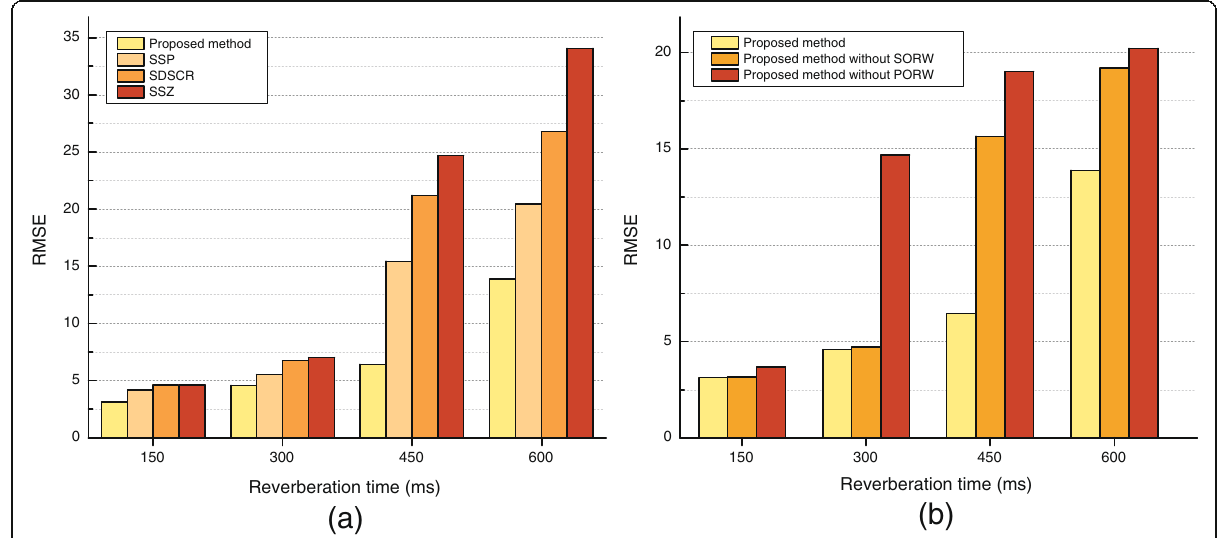
Fig. 9 RMSE of localization results in different reverberation conditions, three sources, separation between adjacent sources is 60°. a The RMSE of localization results using different methods. b The RMSE of localization results using different proposed